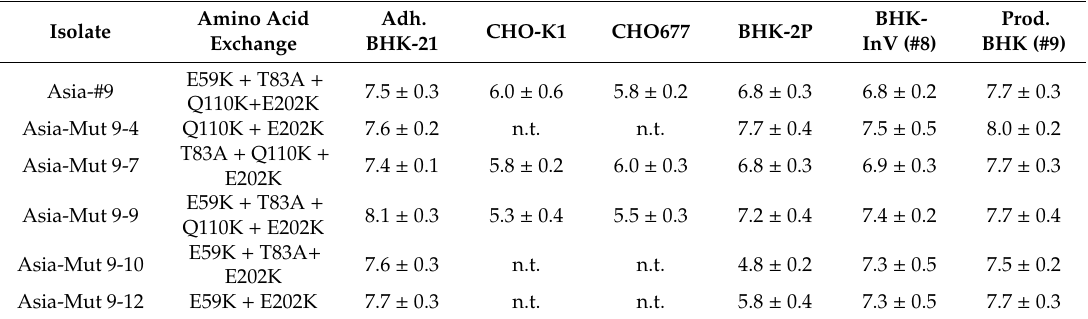
Table 5. Mean and standard deviation of viral titers (log 10 TCID 50 / mL) of virus isolate Asia-#9 and the corresponding recombinant viruses that can infect and replicate in BHK-2P cells. Replication was assumed for all virus / cell combinations for which at least two of three replicate cultures were positive in the FMDV